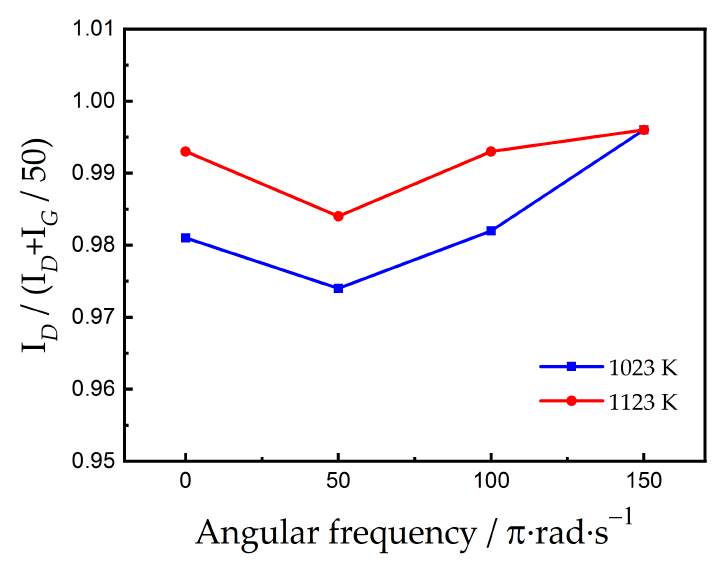
Figure 3. The quality of CVD diamond films under a dynamic magnetic field with different angular frequencies.